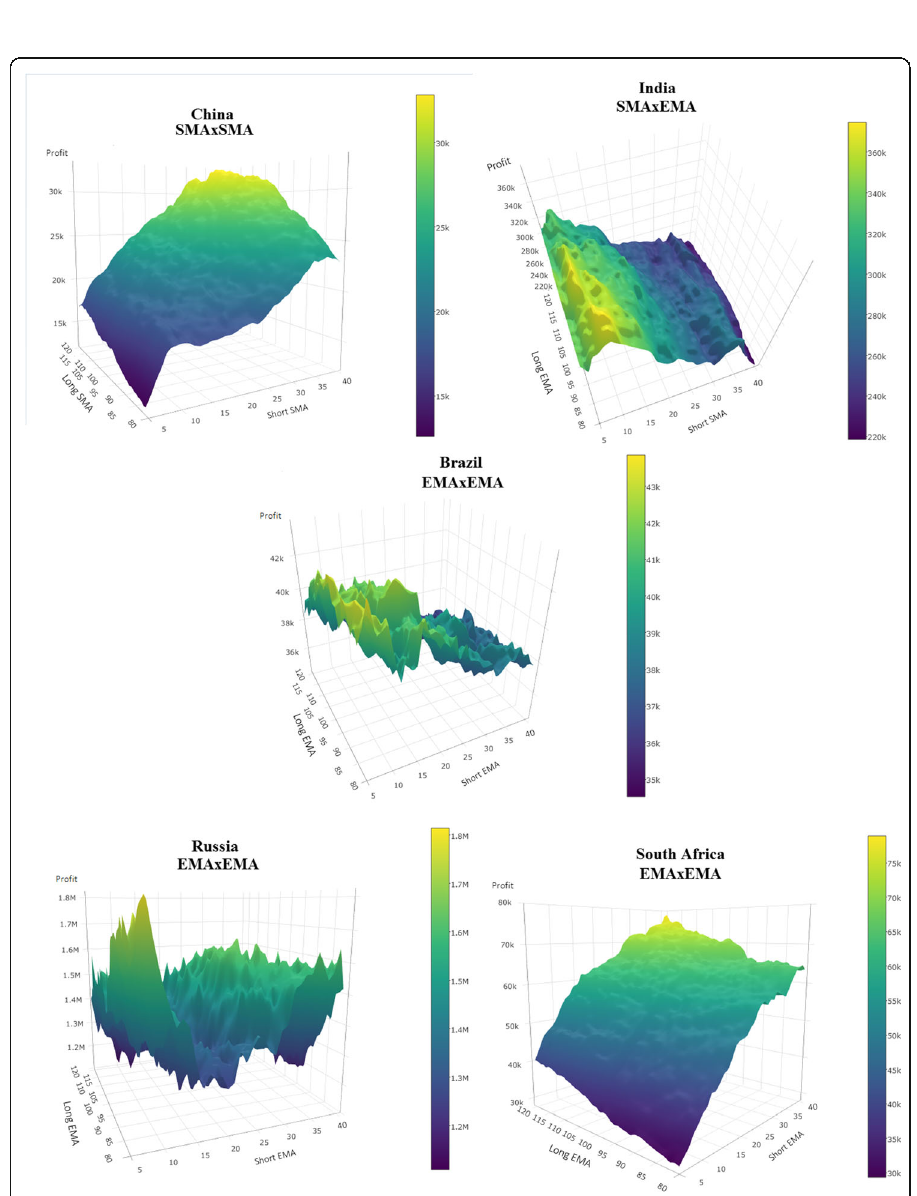
Fig. 2 Example of the graphic